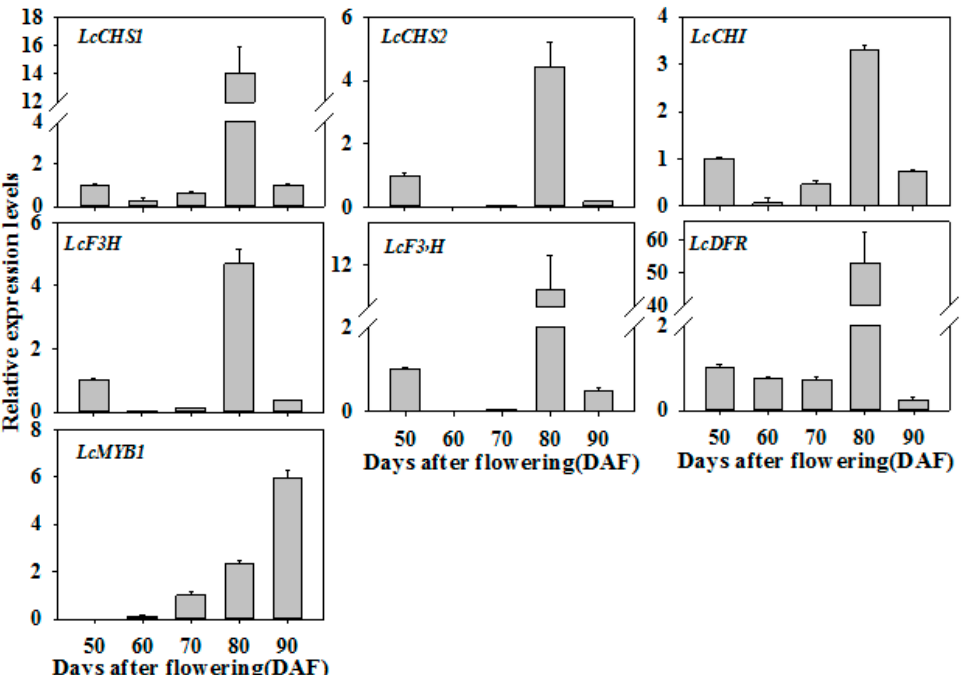
Figure 7. Expression of anthocyanin biosynthesis-related genes in litchi fruit pericarp during ripening. The expression levels of LcCHS1/2, LcCHI, LcF3H, LcF3’H , and LcDFR are expressed as a ratio relative to that at 50 DAF, while the expression level of LcMYB1 is expressed as a ratio relative to that at 70 DAF. Each value represents the mean + standard error of three replicates.